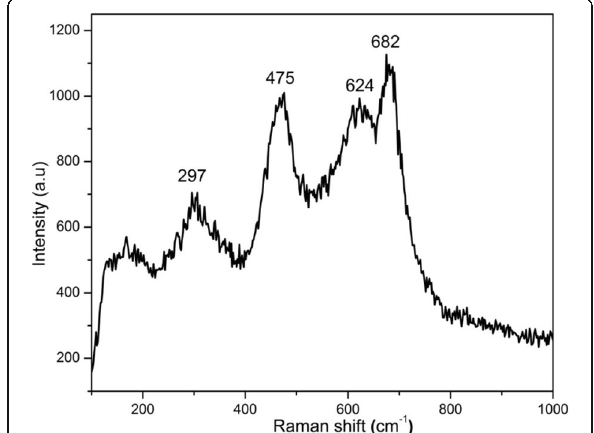
Fig. 4 Room-temperature Raman spectrum of the samples collected in the 190 – 1000 cm − 1 frequency